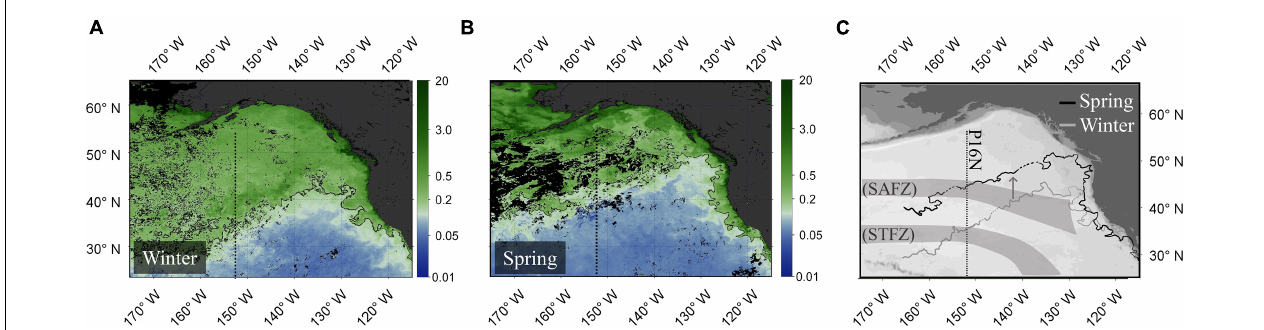
FIGURE 6 | Observed satellite surface chlorophyll a concentrations [mg m − 3 ] in winter (A) , in spring (B) and an overlay of the Transition Zone Chlorophyll Front (TZCF) locations (denoted by the 0.2 mg m − 3 chlorophyll a isopleths) in comparison to SAFZ and STFZ locations (C) . Dotted sections on the contour lines in panel (C) indicate areas with patchy chlorophyll satellite data and are subjectively bridged. Satellite imagery was obtained from Aqua-MODIS for March (winter) and June (spring) 2015 and visualized using NASA SeaDAS software (NASA Goddard Space Flight Center, Ocean Biology Processing Group, 2014).